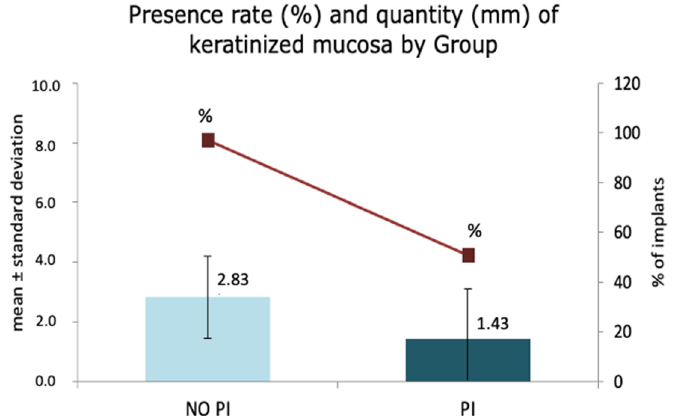
Figure 5. Presence rate (%) and quantity (mm) of keratinized mucosa by Groups. PI (peri-implantitis).